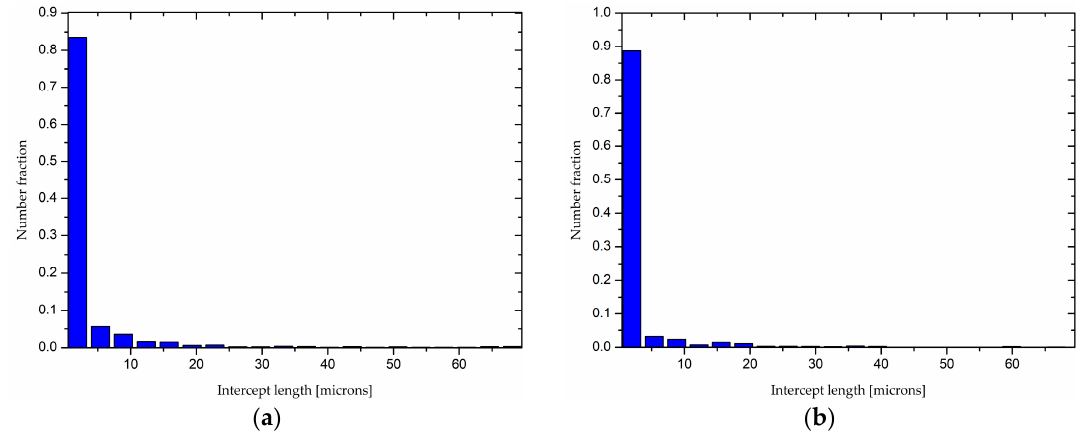
Figure 7. Grain size distribution of the AlMg5 alloy samples ( a ) ST + ECAP 2× + ageing 160 °C for 4 h and ( b ) ST + ECAP 2× + ageing 180 °C for 4 h.